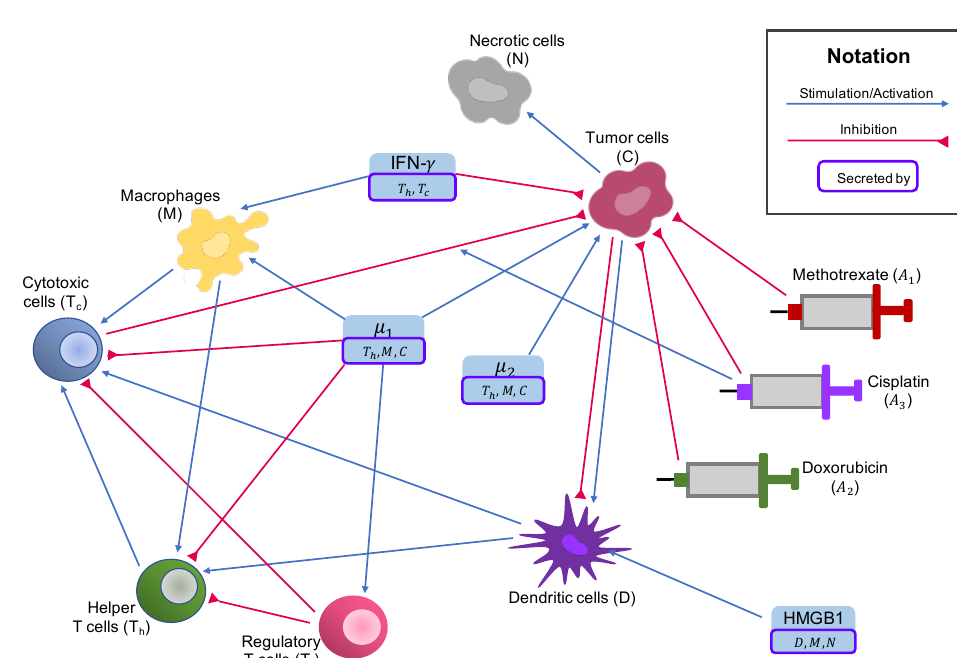
Figure 1. Interaction network with chemotherapy drugs. Activation effects, proliferation effects, and stimulation effects are indicated by blue arrows; and inhibitory effects are indicated by red arrows. Chemotherapy drugs also inhibit all immune cells (red arrows from drugs to immune cells not